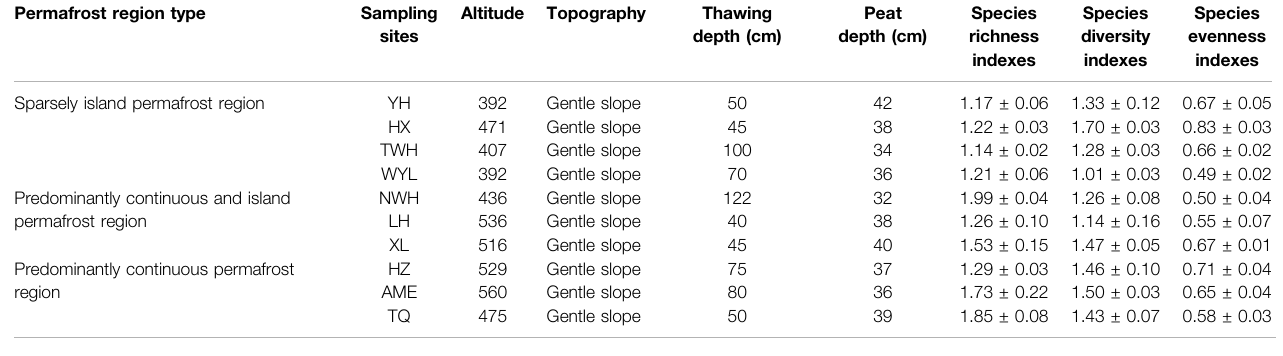
TABLE 1 | The basic information of sampling sites. Permafrost region type Sampling